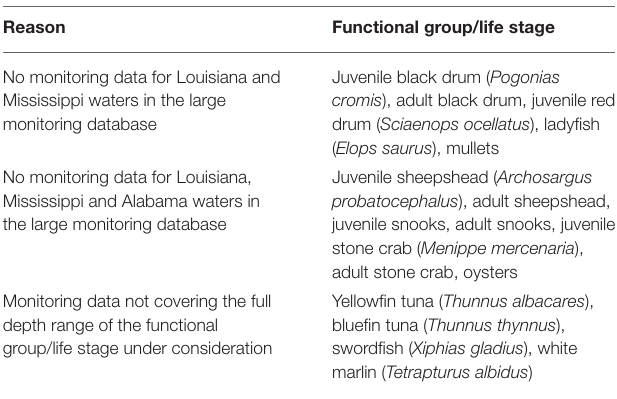
TABLE 4 | Functional groups and life stages for which it was not possible to develop geostatistical binomial generalized linear mixed models in the present